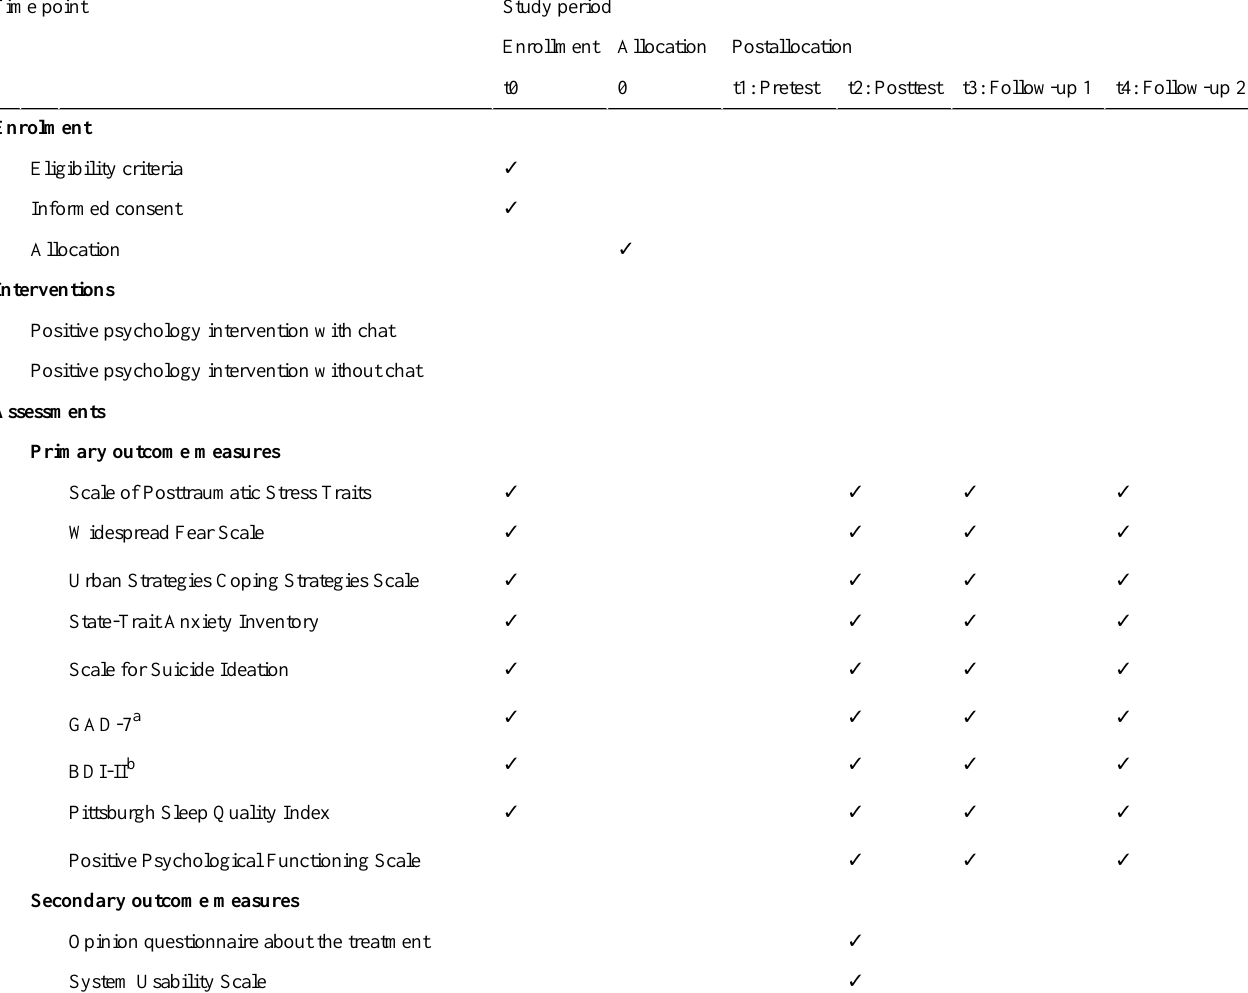
Table 2. SPIRIT (Standard Protocol Items: Recommendations for International Trials) table displaying the schedule of enrolment, interventions, and assessments in the